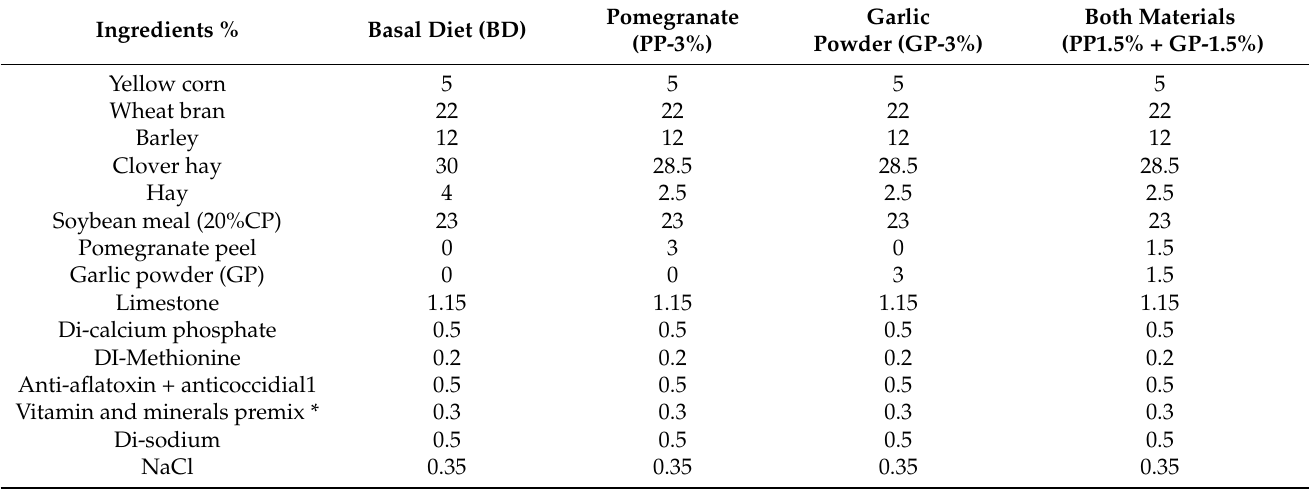
Table 2. Ingredients of the experimental